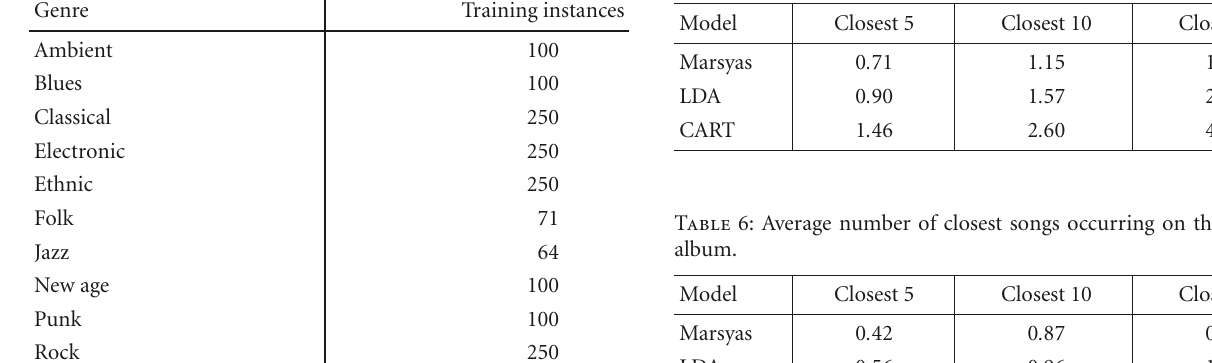
Table 2: Genre distribution used in training models.